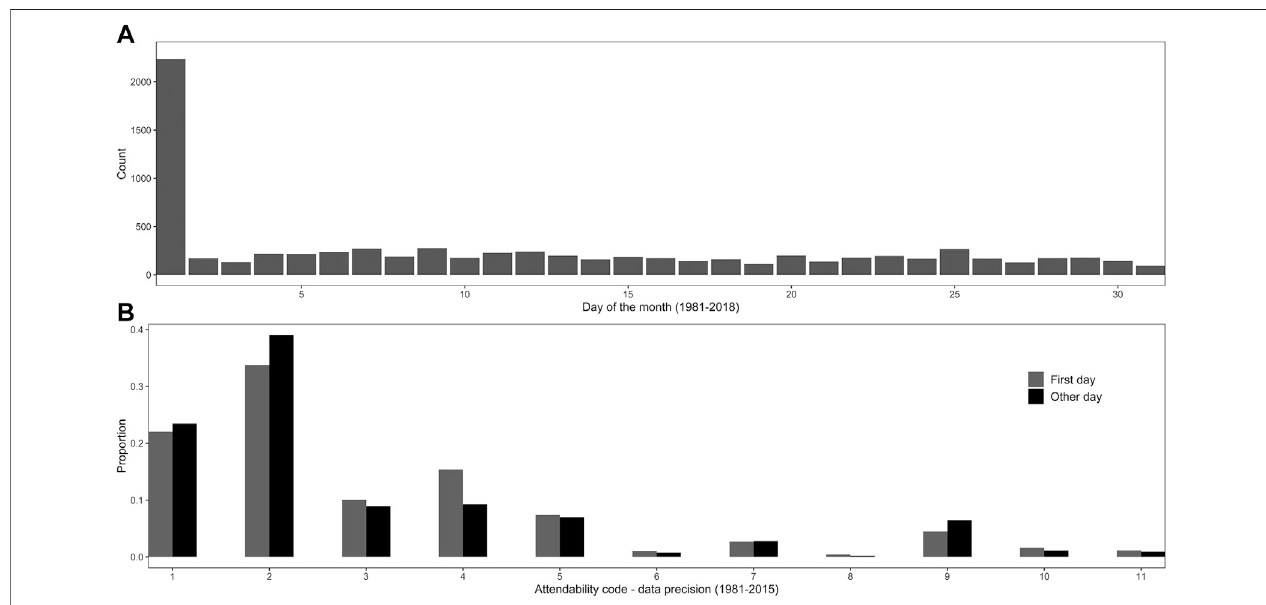
FIGURE 5 | Distribution of landslides by day of the month (A) and in relation to the accuracy code provided (B) . The dataset includes an “ accuracy code ” , which should give an idea of the precision of the date. A landslide with code 1 indicates a claimed daily precision of dating, while code 2 means a short period precision (1 − 7 days).Codes 3to7indicate amonthly,bimonthly,seasonal,biannual and yearlyprecision. Code8stands foramultipleyearprecision, while 9and 10 indicate the date on the document or an uncertain date. Finally, 11 stands for events with unknown accuracy.